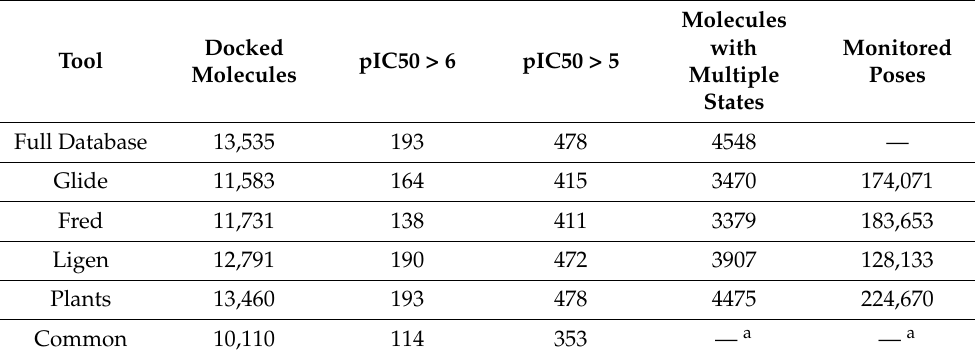
Table 1. General characteristics of the databases simulated by each docking program and relative generated